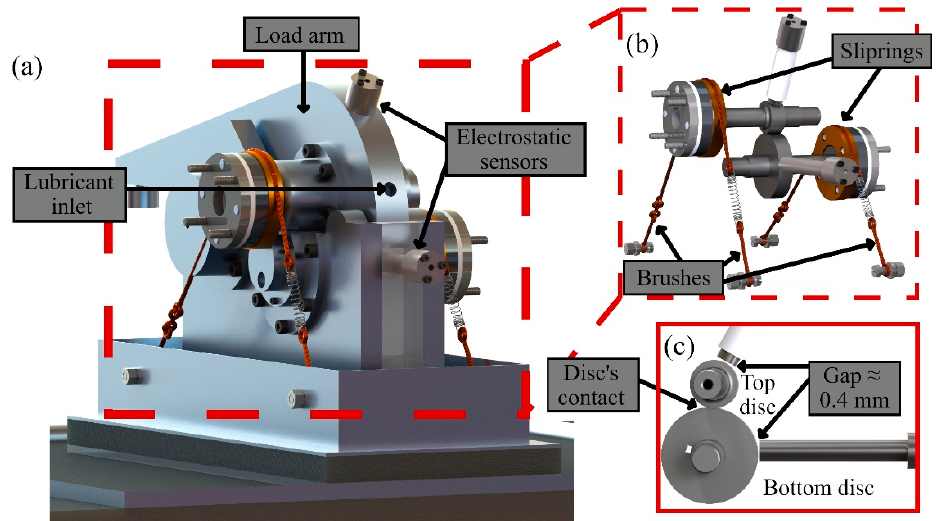
Figure 2. ( a ) A 3-D model of the TE74 twin-roller machine, showing the applied radial load using a ( b ) A 3-D model showing the top and bottom discs and positions of the two ES sensors. ( c ) A